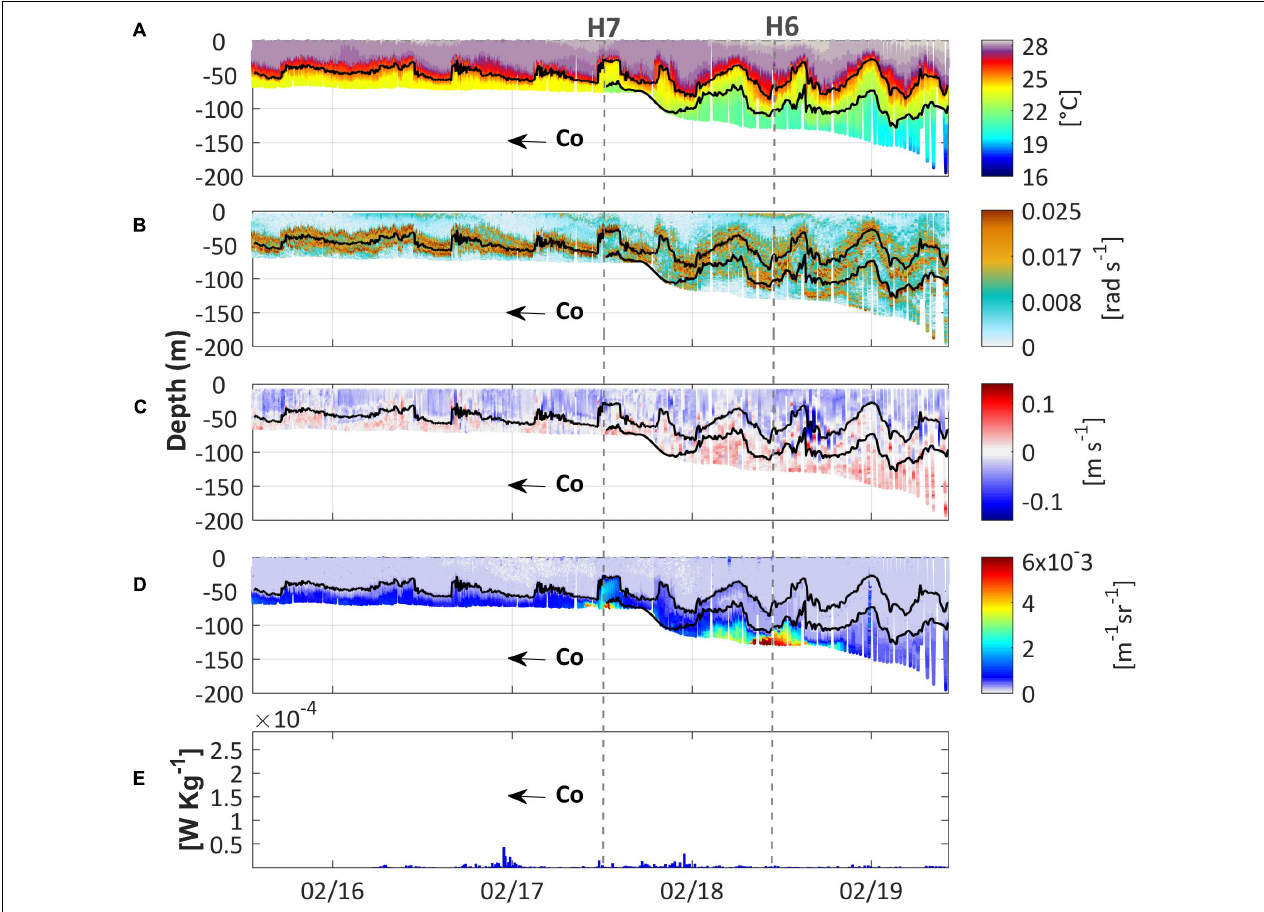
FIGURE 14 | As in Figure 13 , but (A–E) for February 2014. The 22 and 25 ◦ C isotherms are displayed on each panel (black solid lines). The color bar of the temperature field differs from that of Figure 13 .